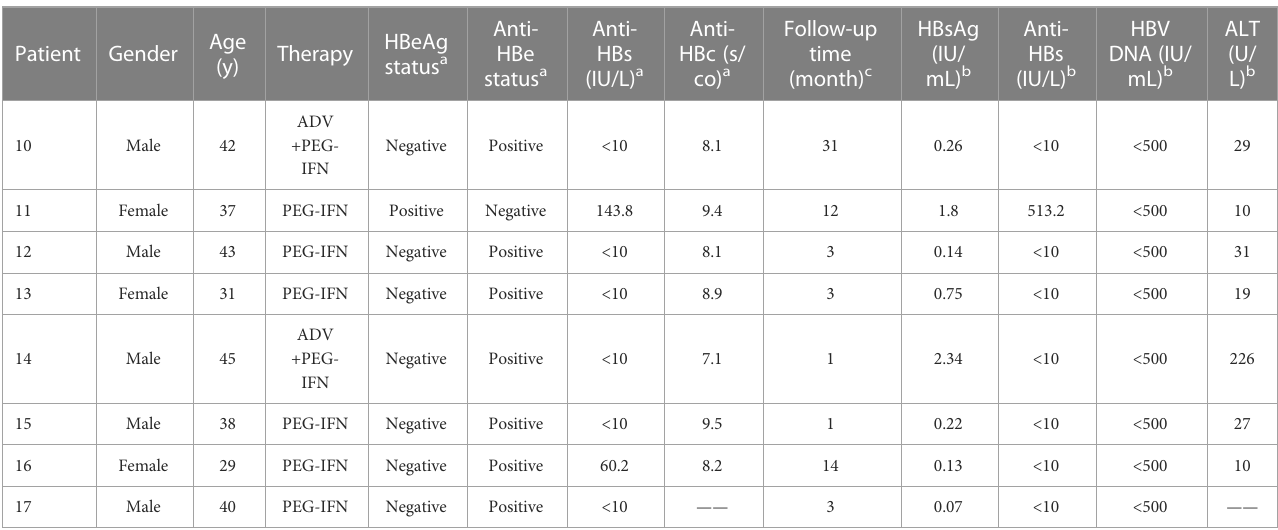
anti-HBc from 6 to 36 months in